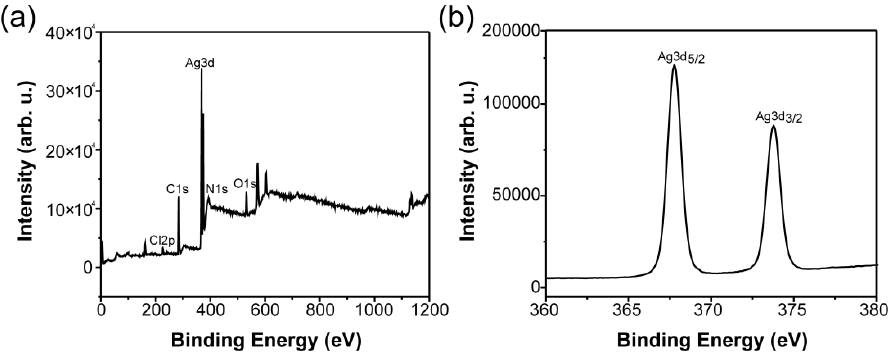
Figure 4. XPS spectra of AgNPs-PEM-SS/Agar film ( a ) and Ag (3d) electron binding energy spectrum ( b ).